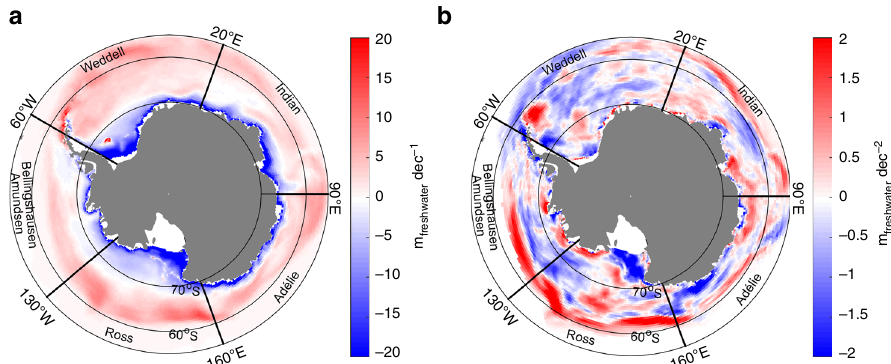
Fig. 6 1979 – 2013 freshwater equivalent fl ux resulting from sea-ice formation and melting in the model. a Mean fl ux in the ice-covered region of the Southern Ocean, as simulated by NEMO-LIM3.6. b Trends in freshwater equivalent fl ux over 1979 –